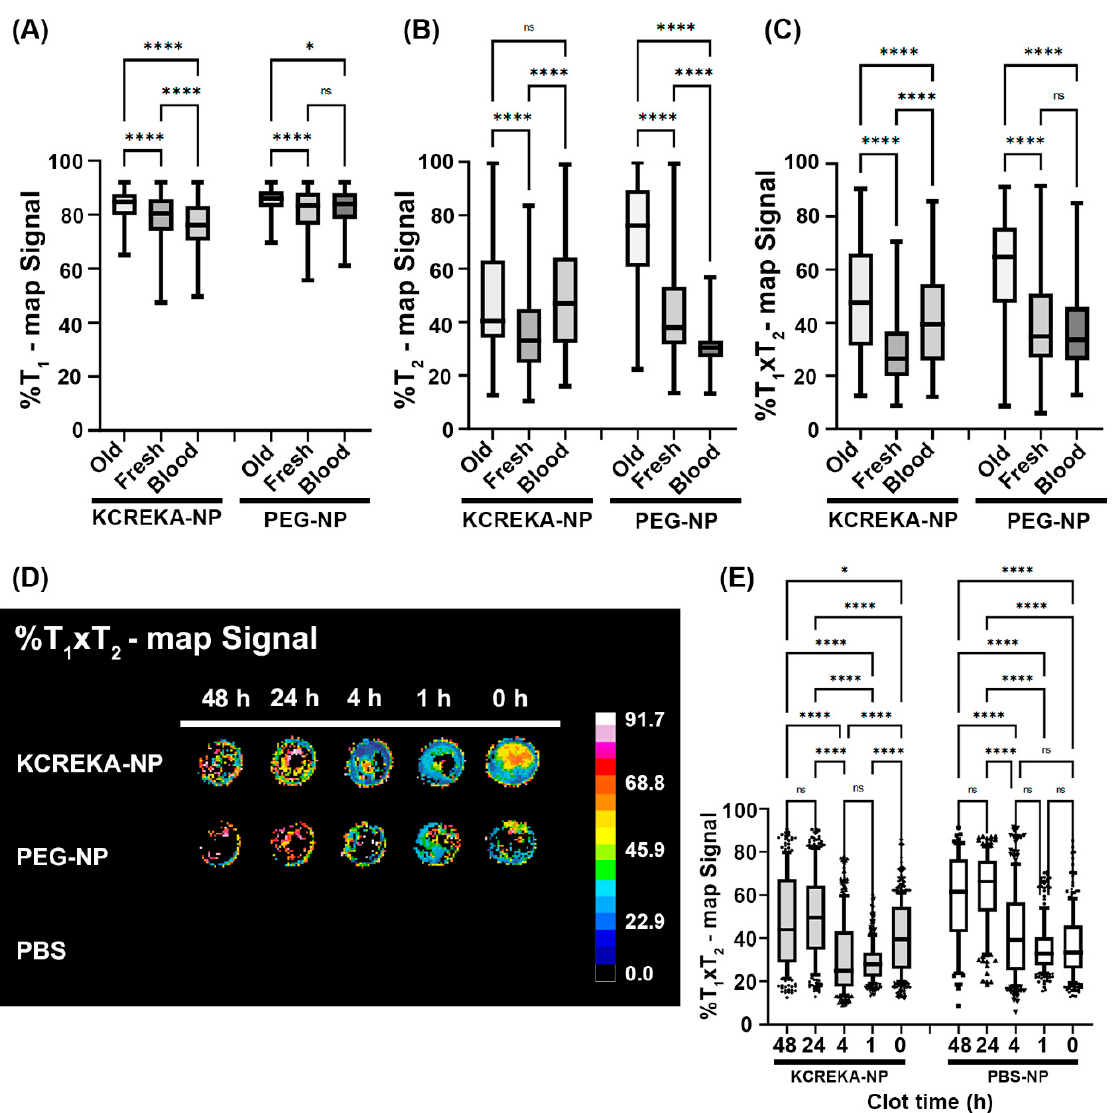
Figure 5. ( A – D ) MRI images and median values of the decreases in T 1 , T 2 , and T 1 × T 2 weighted images in relation to the background signal for old clots, fresh clots, and blood incubated with KCREKA-NPs, PEG-NPs, or PBS. ( E ) Detailed images of the blood clots with different aging times. * p < 0.05, **** p < 0.0001 using one way ANOVA followed by Kruskal-Wallis test.